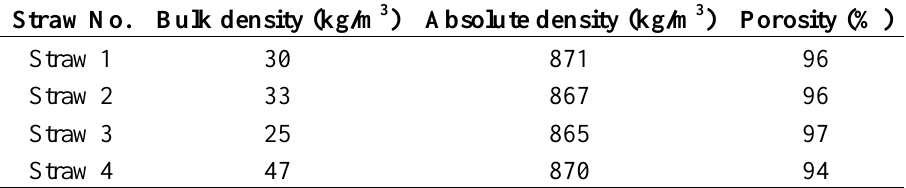
Table 1. Densities and porosities of the different types of